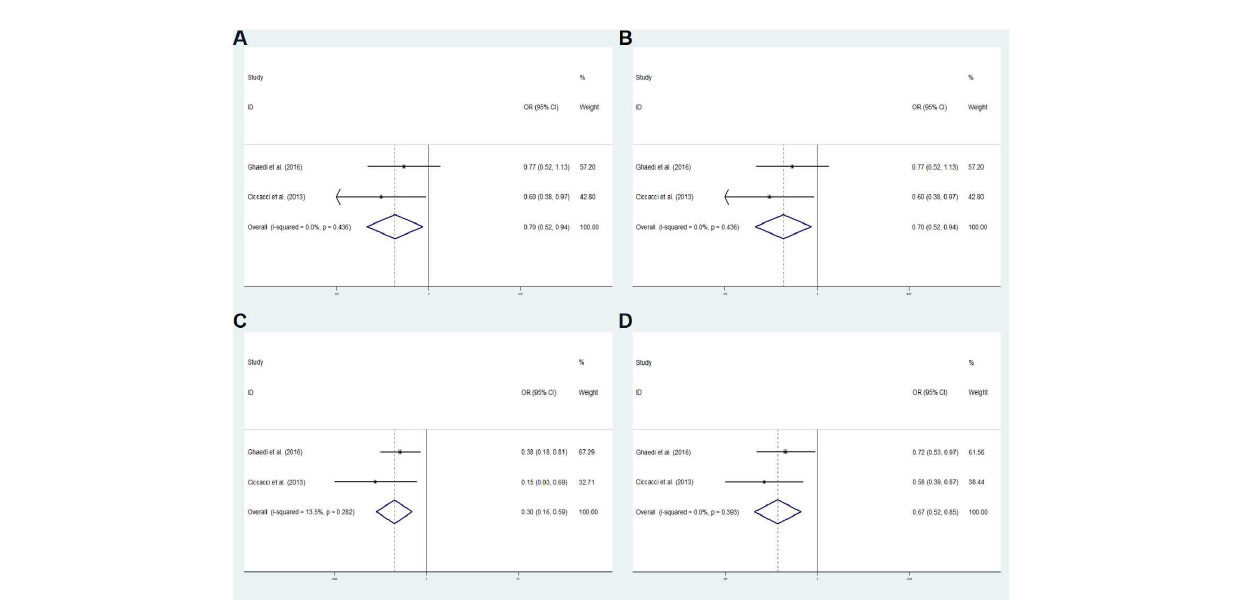
FIGURE 4 Subgroup meta-analysis for the association between miR-27a rs895819 and T2DM susceptibility in a Caucasian population in fi xed effects model. (A) Dominant model, CC+TC vs. TT. (B) Recessive model, CC vs. TC+TT. (C) co-dominant homozygous model, CC vs. TT. (D) Allele model C vs. T. OR odds ratio, CI, con fi dence interval; I2: measurement to quantify the degree of heterogeneity in